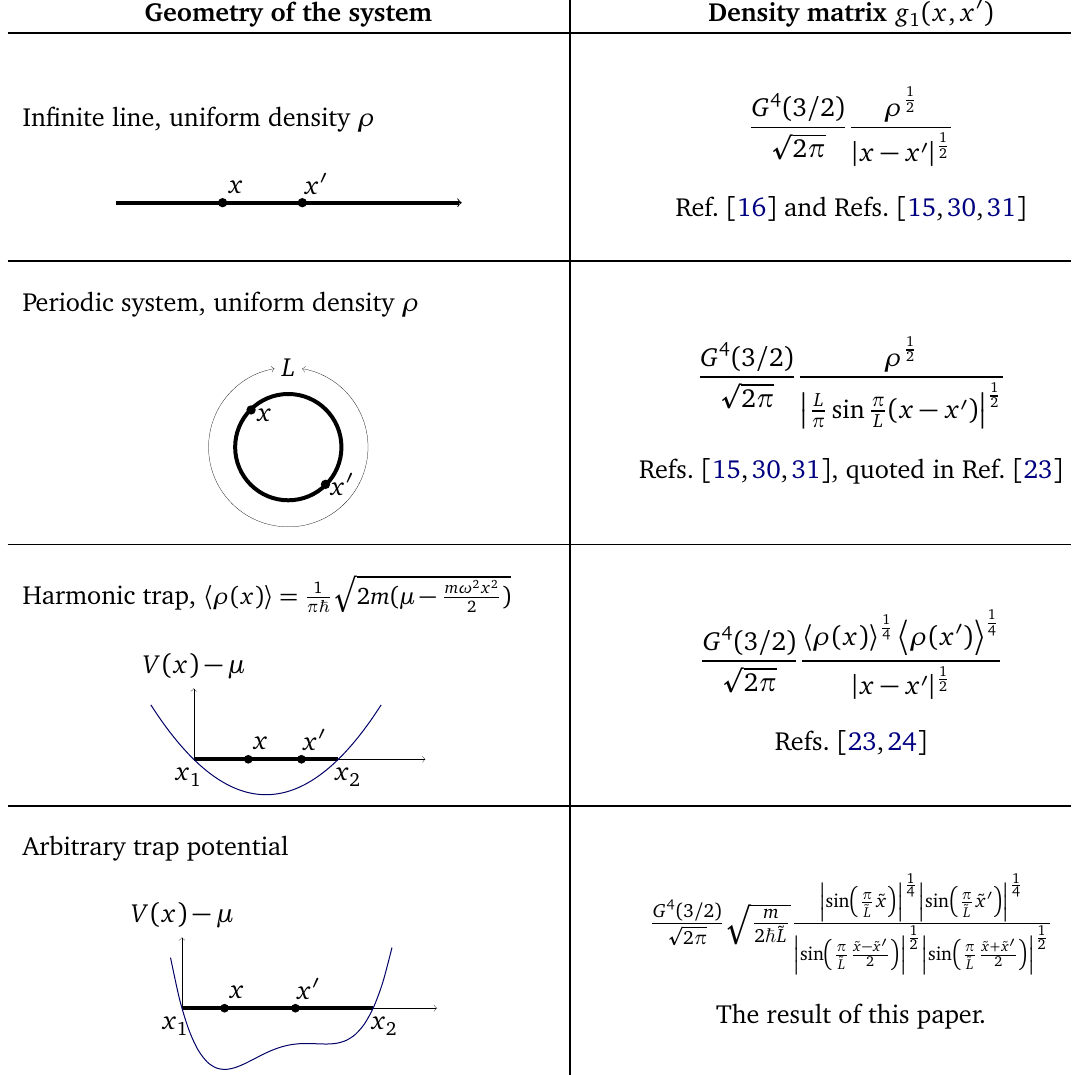
( x , x (cid:48) ) of the Tonks-Girardeau gas for different geome- Table 1: One-particle density matrix g 1 tries. The first three lines correspond to known results in the literature. The fourth line is the main result of this paper, with ˜ x defined in Eq.